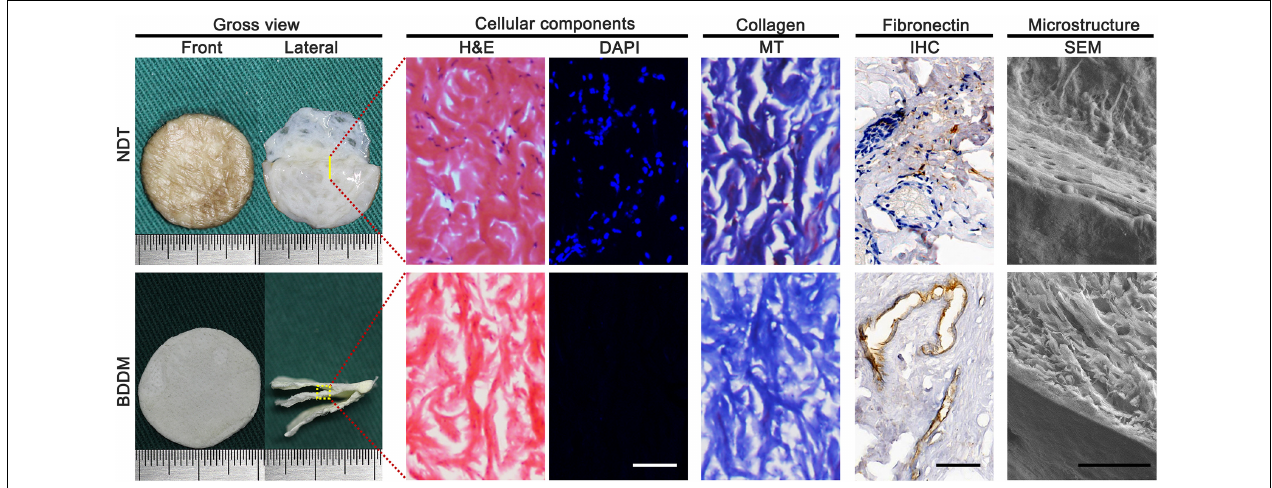
FIGURE 2 | Gross observation, cellular components, collagen and fibronectin preservation, the microstructure of the native dermal matrix, and book-shaped decellularized dermal matrix. Bar = 100 µ